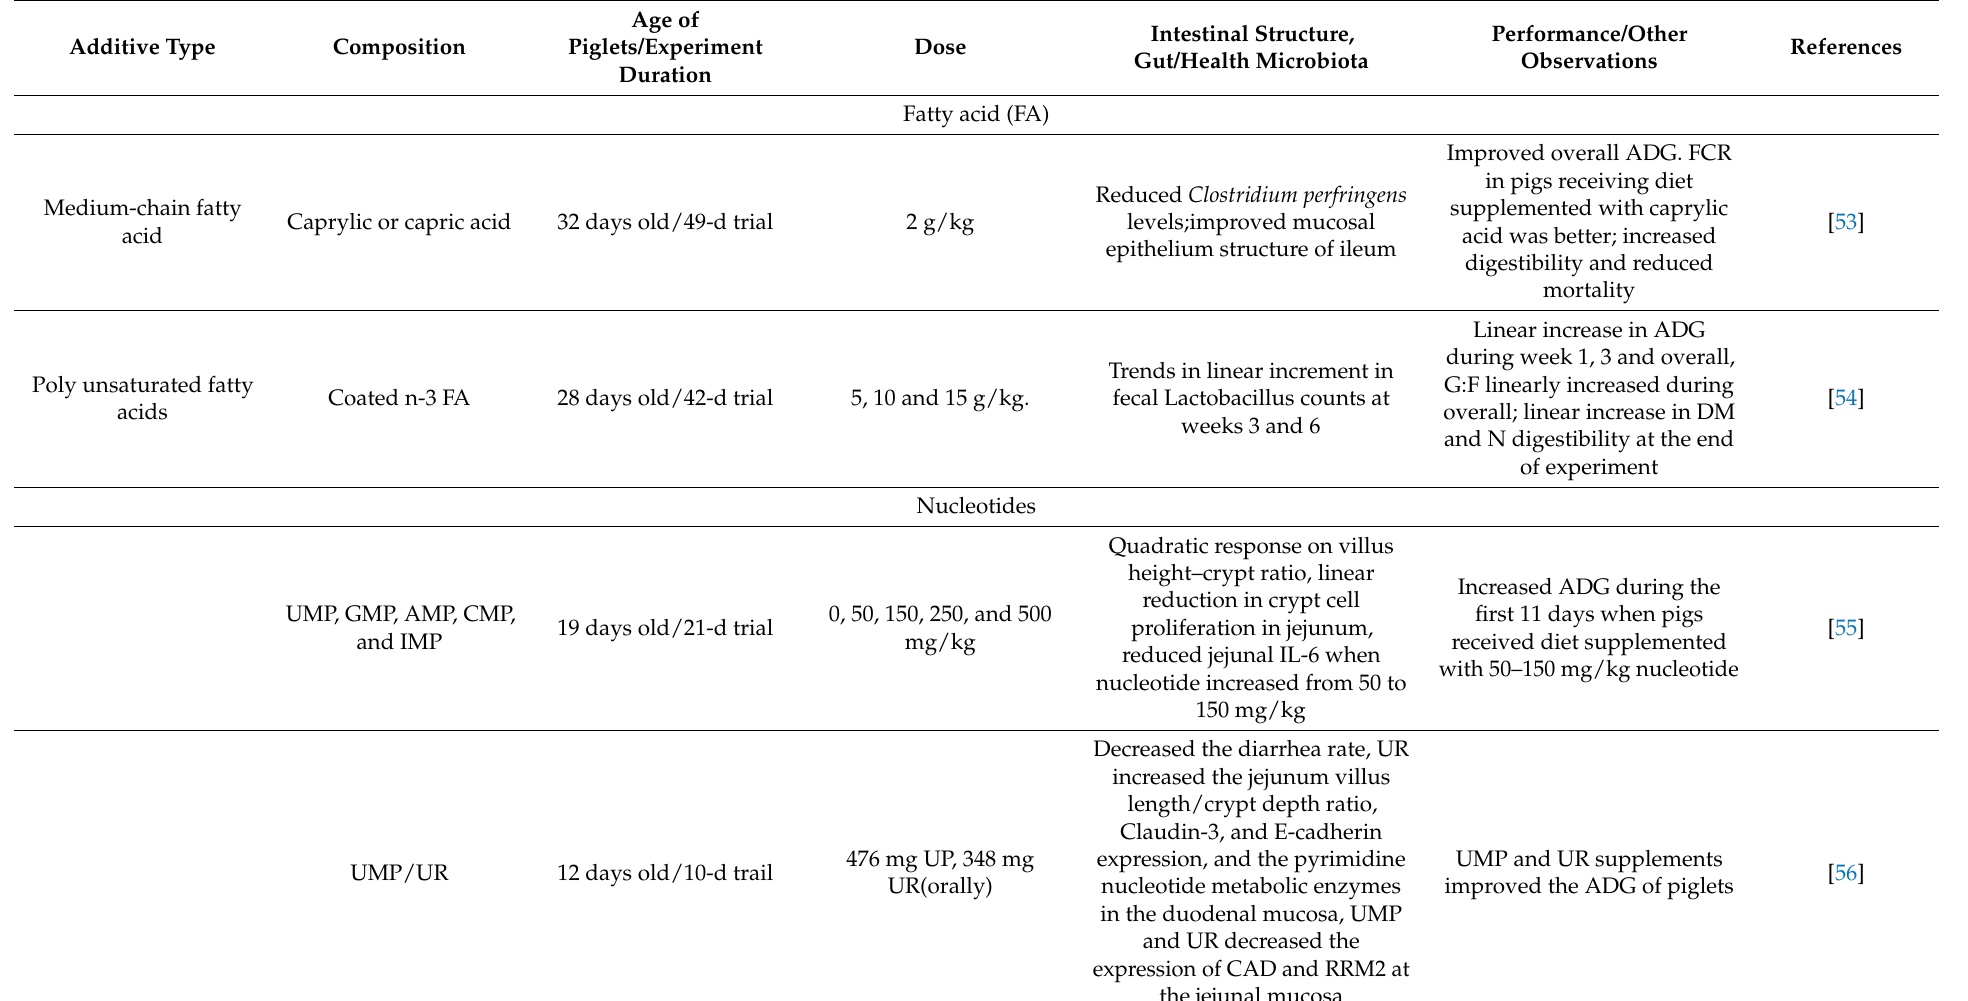
Table 1. Effects of different types of feed additives on gut health and performance of young